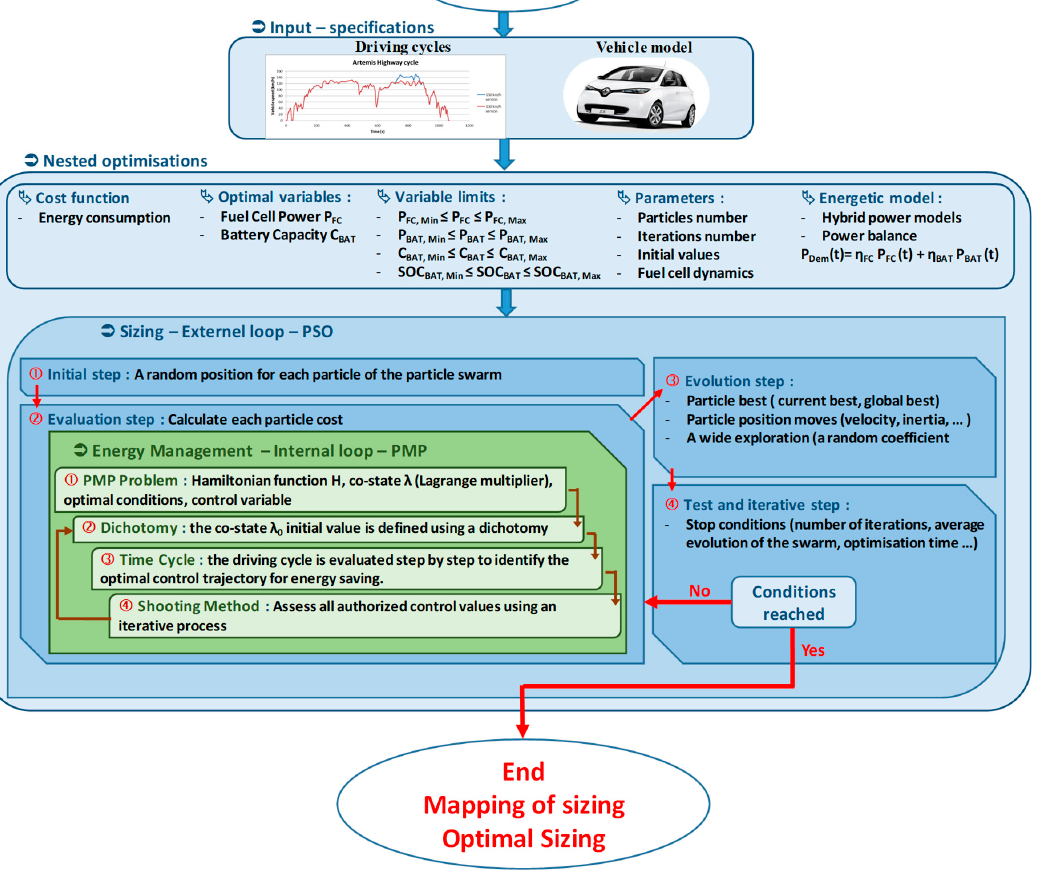
Figure 2. Workflow implementing the proposed nested optimization approach.